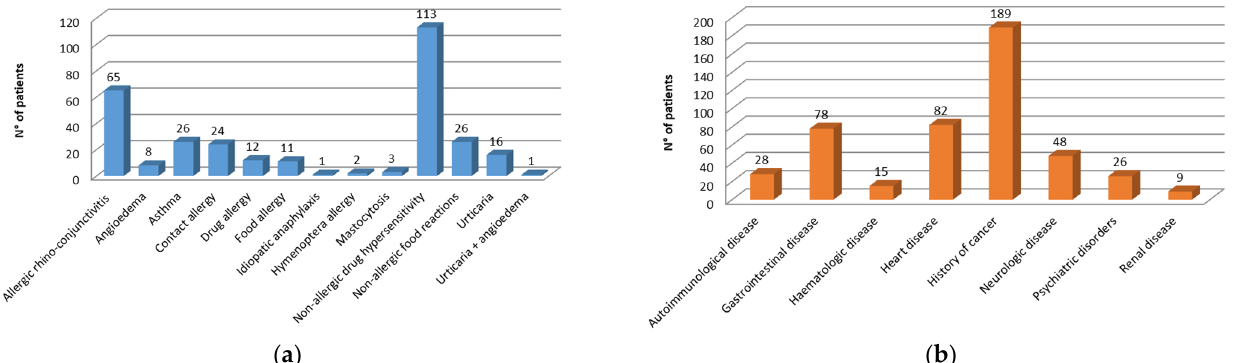
Figure 2. Frequency of comorbidities: ( a ) comorbid allergic/hypersensitivity; ( b ) comorbid non-allergic diseases.